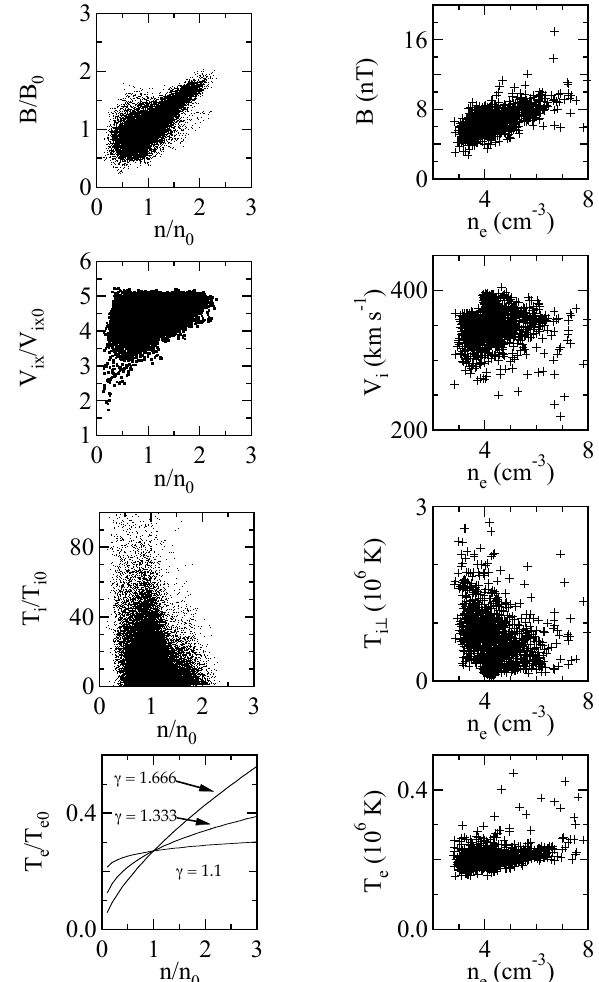
Fig. 5. Scatter plots of velocity, temperature, and magnetic field strength versus density for observations within the box shown in Fig. 1 and the Cluster observations shown in Fig.